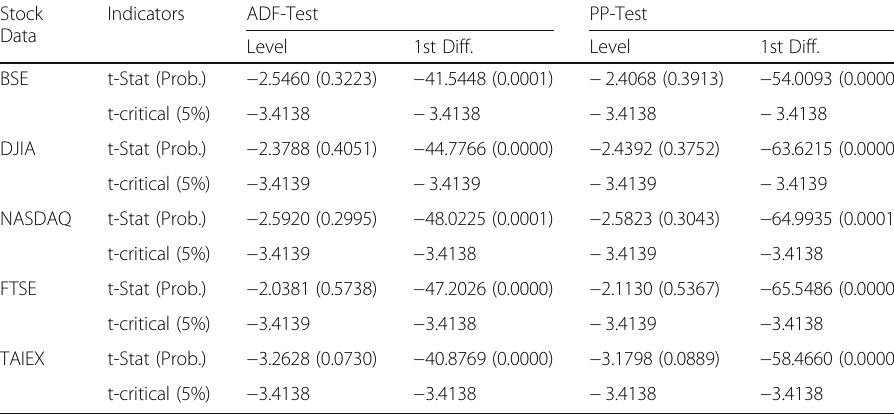
Table 4 The results from Augmented Dickey-Fuller test and Phillips-Perron test for five financial time